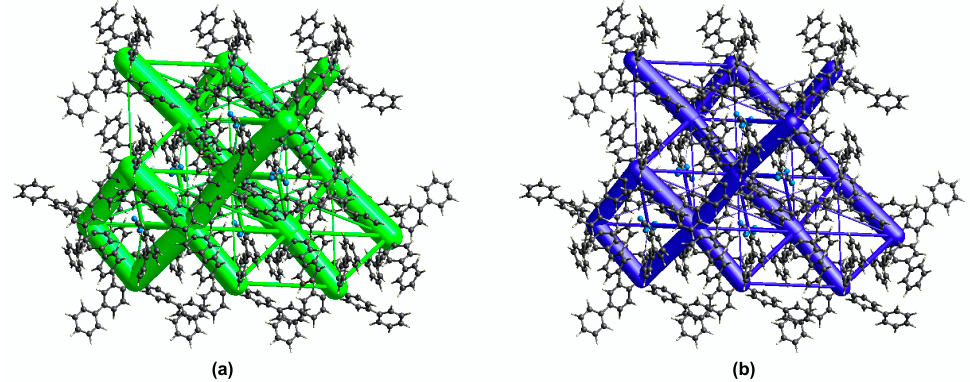
Figure 6. Energy frameworks for 1, representing ( a ) the dispersion energy (green colour) and ( b ) the net interaction energy (in blue colour).